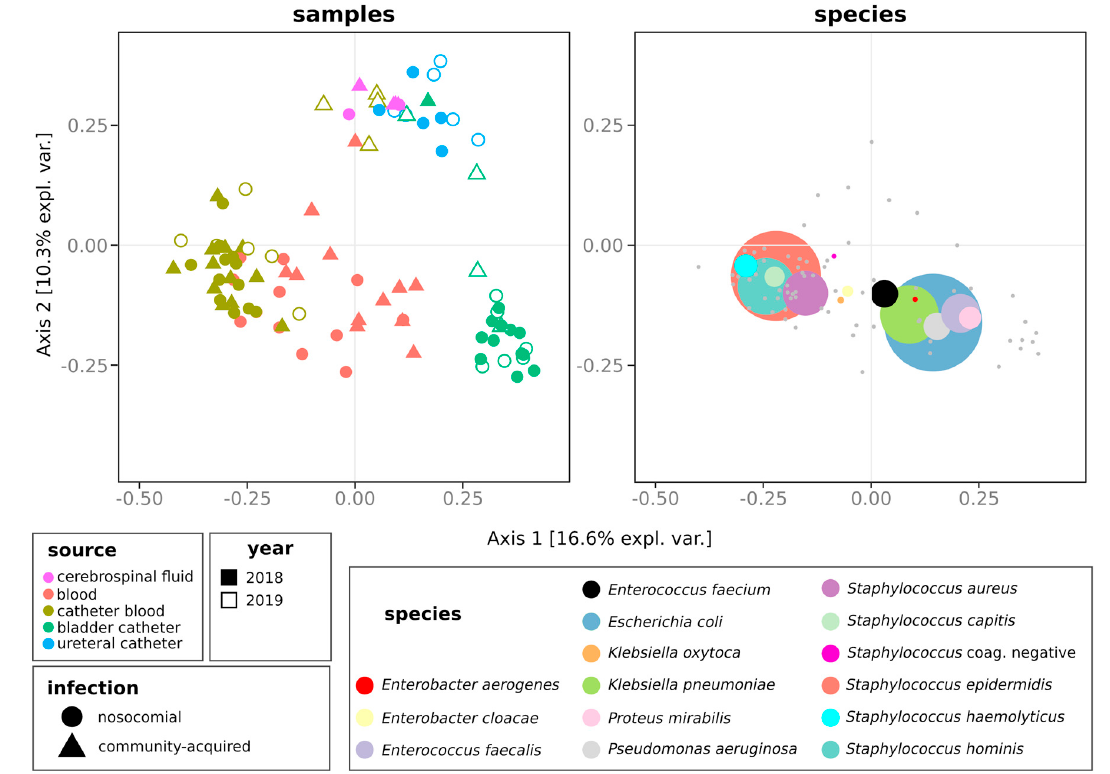
Figure 3. Comparison of the composition of groups of isolates. Distribution of variables over the first two components of the principal coordinate analysis (PCoA) carried out on Jaccard distances. Strains isolated at the same time (month and year) from the same type of specimen (blood, catheter blood, bladder catheter, ureteral catheter, or cerebrospinal fluid) and recognized as having the same origin (nosocomial or community- acquired) were considered as belonging to the same group. Left: first two coordinates of the PCoA. Right: the same PCoA plot with the fifteen most abundant species (showing the highest average relative abundance across the dataset) overlaid as colored points with a size proportional to the mean relative abundance of the taxon across all groups of isolates. Species coordinates were calculated as the weighted average across groups of samples coordinates. Grey dots in the right plot represent the coordinates of species present at lower abundances.